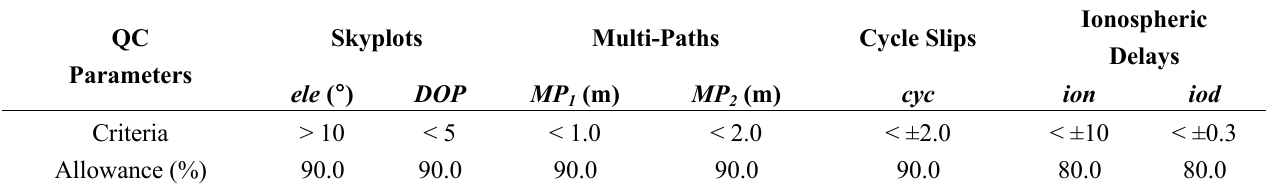
Table 2. Criteria and allowance of quality